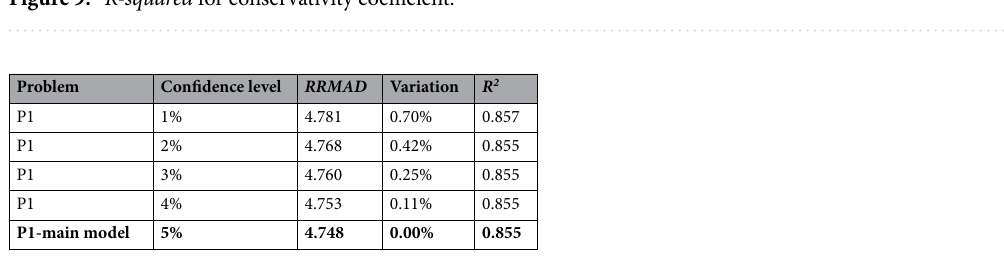
Table 7. Analyzing the confidence level. Significant values are in